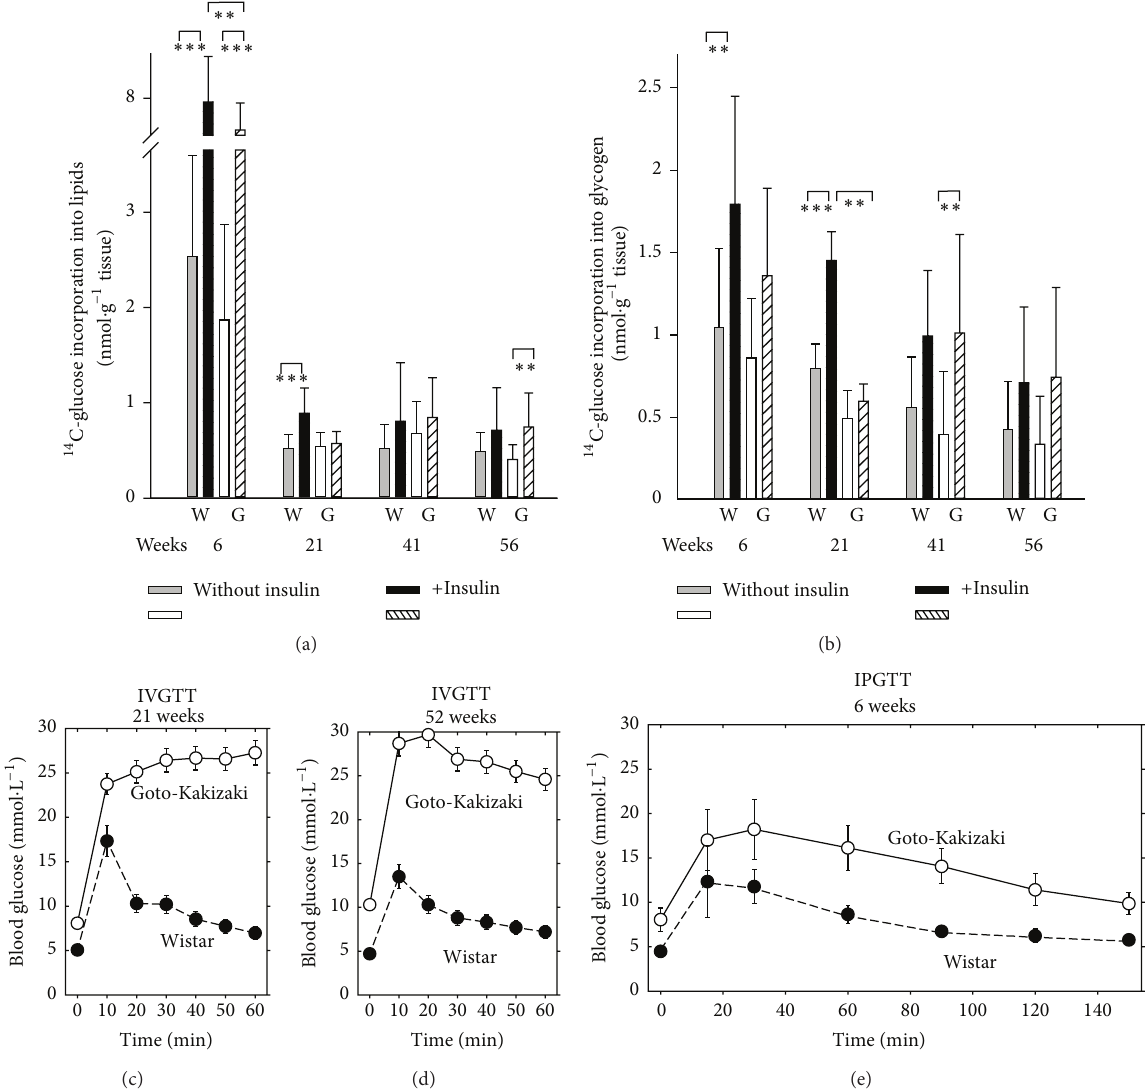
Figure 9: In vitro insulin sensitivity (a, b) and in vivo insulin resistance (c, e) of Goto-Kakizaki rats. (a) and (b) 14 C-glucose incorporation into lipids (a) of epididymal adipose tissue and into glycogen of diaphragm (b); in vitro data obtained in the absence ( gray or white bars ) or presence of an insulin stimulus ( black or dashed bars ) in four selected age groups at indicated week of age are plotted for Wistar “W” and Goto-Kakizaki rats “G.” ∗∗ ANOVA yielded 𝑝 < 0.05 from the following ensembles: 𝑛 = 18 –20 in (a) for 6 and 41 weeks, 𝑛 = 9 –12 in (a) for 6 and 41 weeks, and 𝑛 = 8 –10 in (b). (c)–(e) Intravenous glucose tolerance test “IVGTT” or (f) intraperitoneal glucose tolerance test “IPGTT” during aging of Wistar and Goto-Kakizaki rats. Blood glucose levels are indicated within the given time course after addition of glucose (see Section 2.1 for details) for a group of six rats of the given age as